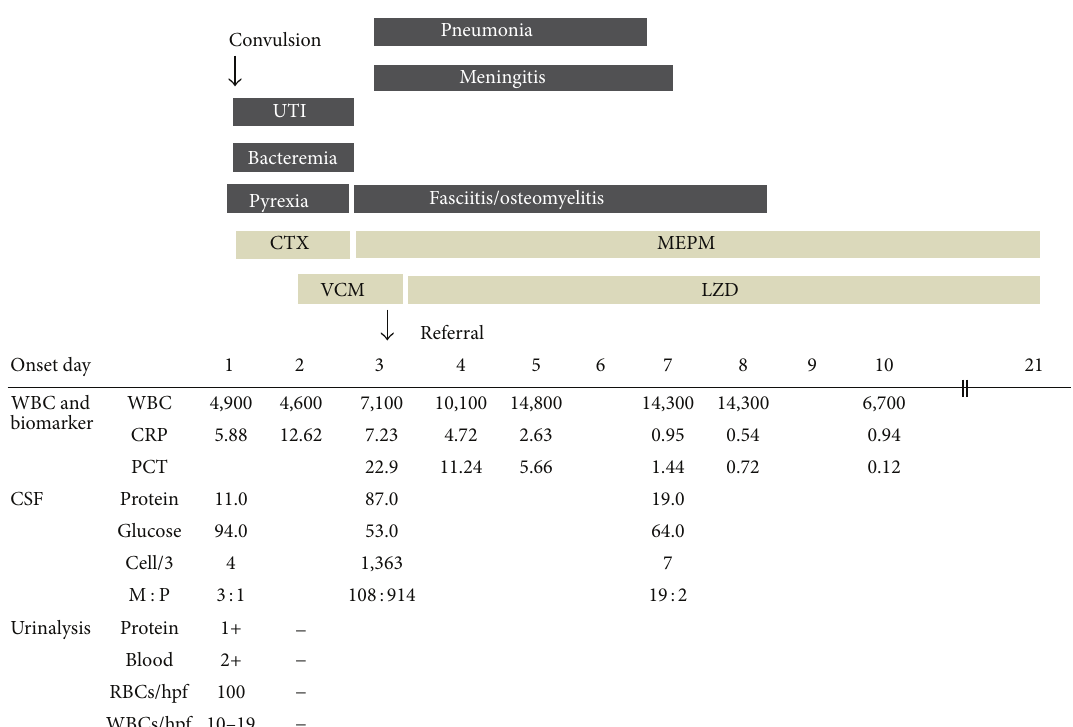
Figure 2: Clinical course of a 23-month-old Japanese girl with meningitis, osteomyelitis, fasciitis, necrotizing pneumonia, urinary tract infection,andsepsisduetocommunity-acquiredmethicillin-resistant Staphylococcusaureus .UTI,urinarytractinfection;PCT,procalcitonin; VCM, vancomycin (55 mg/kg/day); LZD, linezolid (30mg/kg/day); CTX, cefotaxime (100mg/kg/day); MEPM, meropenem